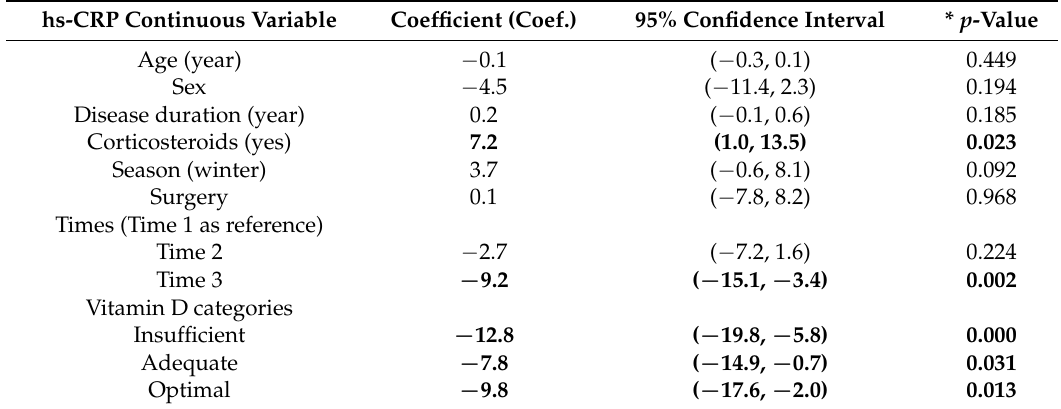
Table 4. Factors Associated with Hs-CRP Levels among Crohn’s Disease